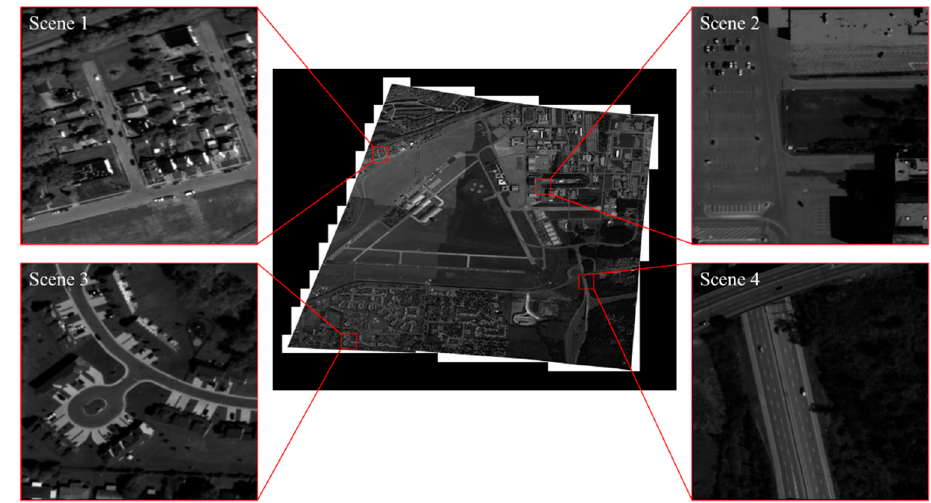
Figure 4. The complicated scenes in UNCIRON 2008